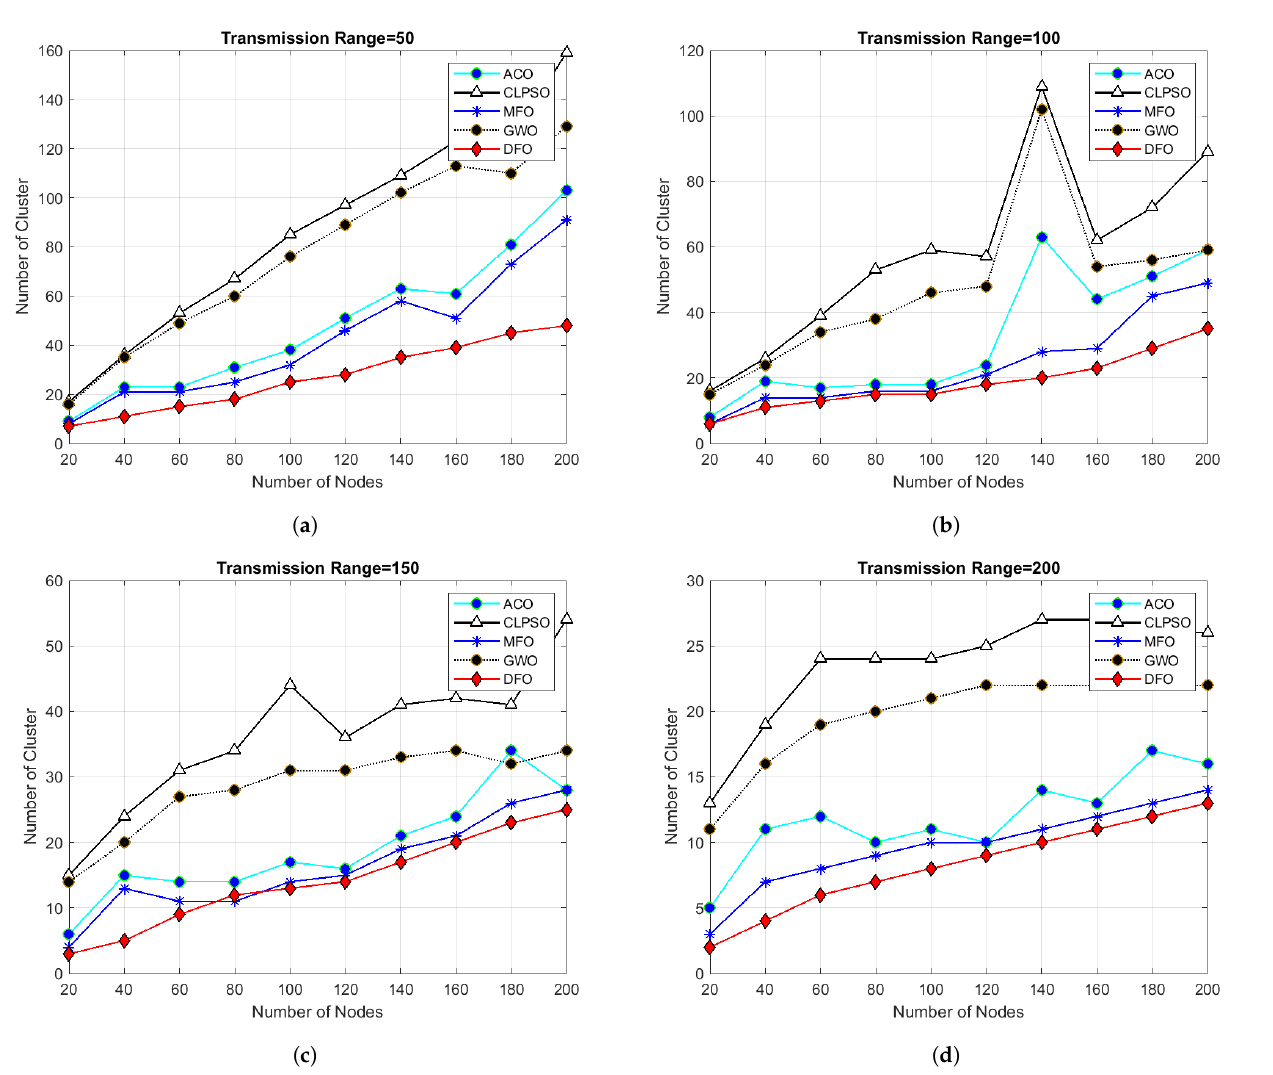
Figure 7. Grid size 2000 m × 2000 m and number of nodes 20 to